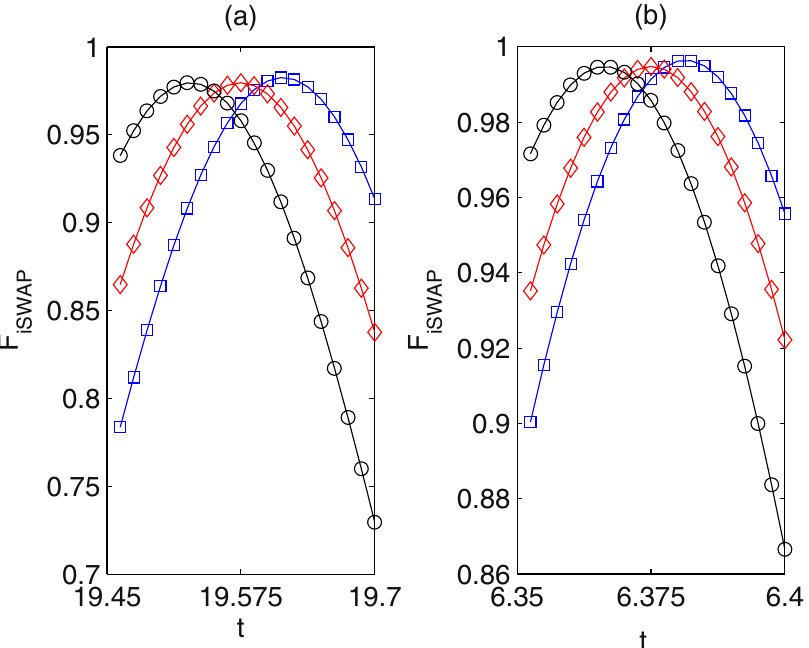
, δ ∆ = + g 9 , ν = 4 g , 1 2